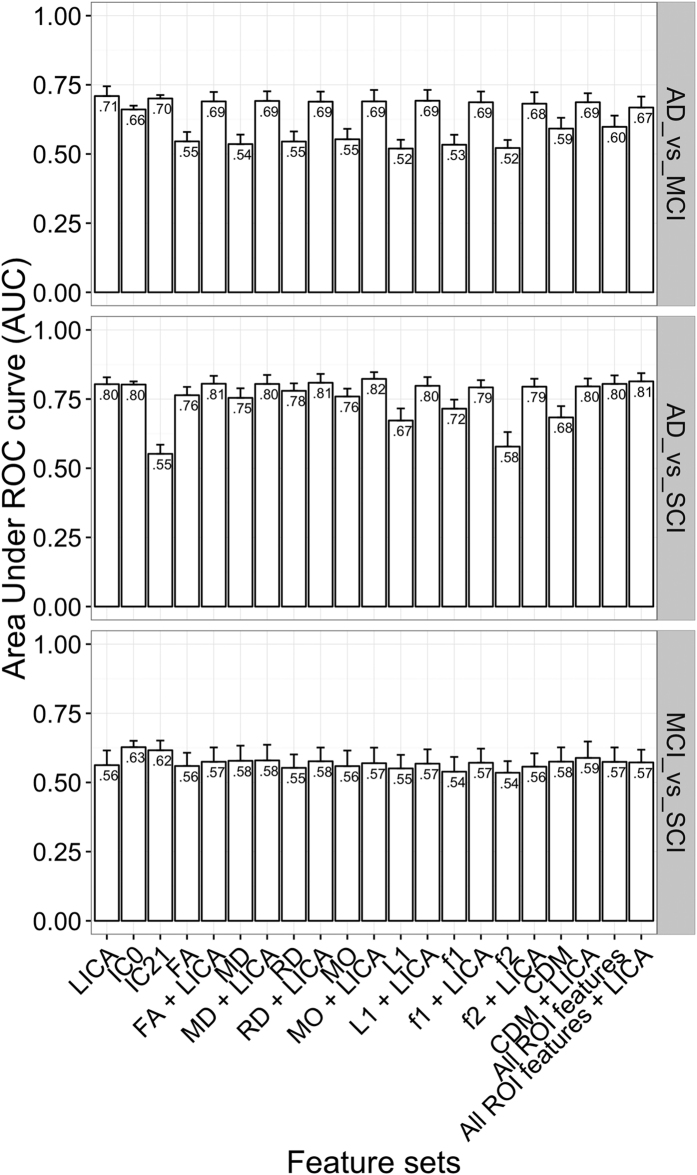
Classification performance.AUC = Area Under ROC curve. The bars represent the mean AUC across 100 iterations and the upper error bars represent the standard deviation. LICA = feature set comprising all LICA components. All ROI features = the combined set of all ROI features (24 features * 8 diffusion MRI metrics). PCA was applied to the ROI feature sets prior to training a classifier.